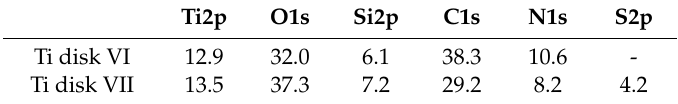
Table 2. X-ray photoelectron spectroscopy (XPS) elemental composition (at%) of Ti disks (VI) and (VII). Ti2p